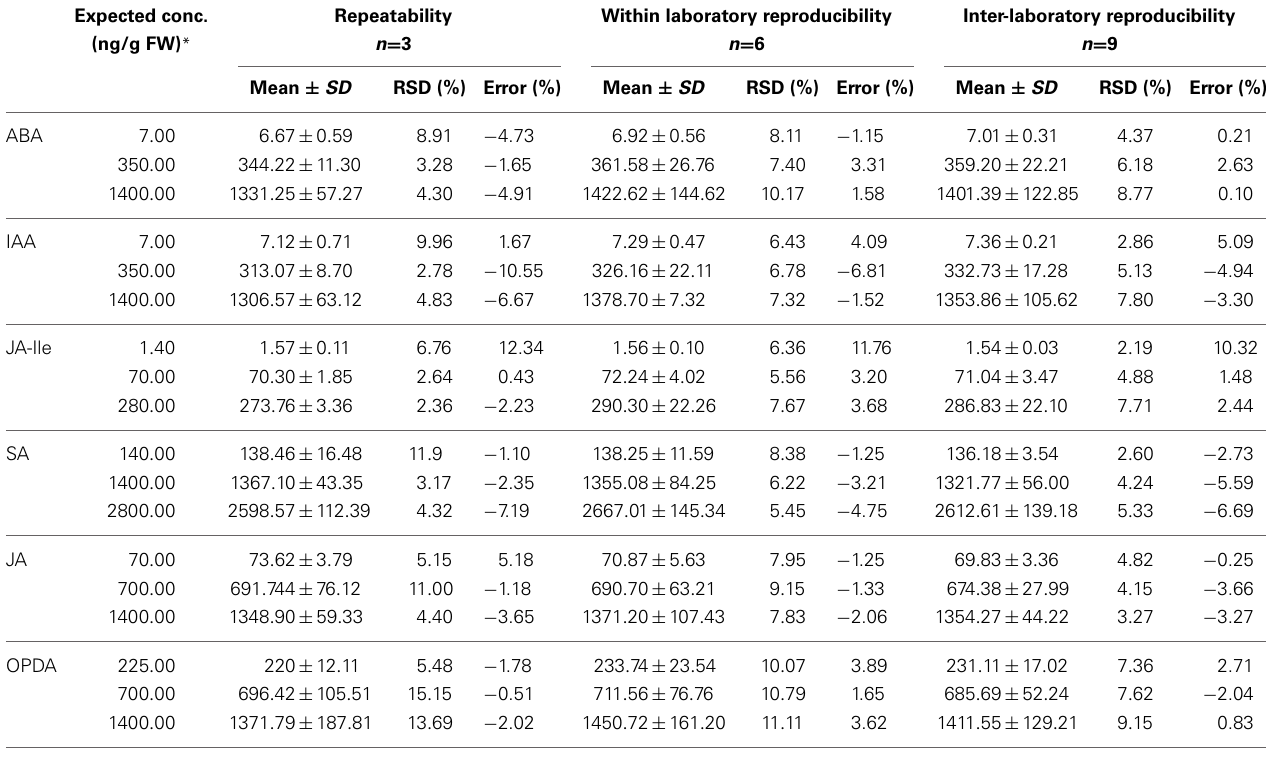
Table 3 | Values of repeatability, within-laboratory reproducibility and inter-laboratory reproducibility obtained during the validation of the method for quantification of various phytohormones (ABA, IAA, JA-Ile, SA, JA, and OPDA) in Arabidopsis thaliana . Expected